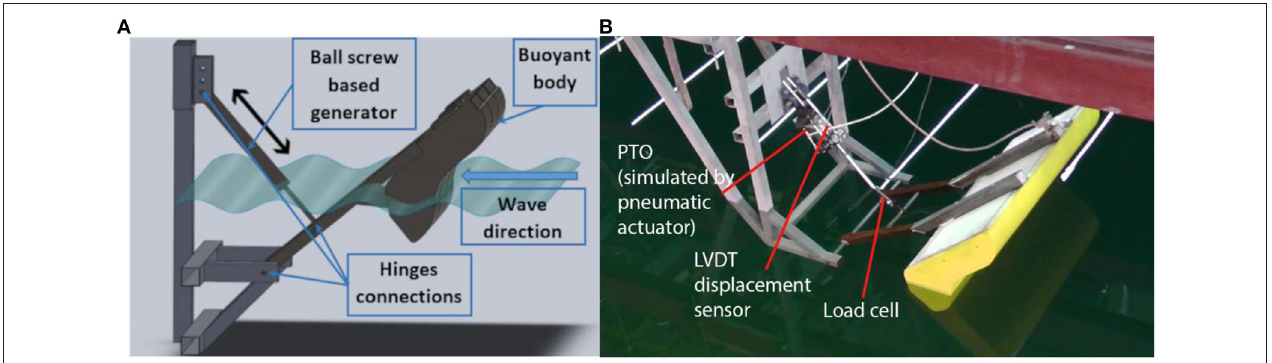
FIGURE 8 | Wave scatter matrix for a Tyrrhenian sea site, near Civitavecchia, derived from sea state time histories (2001–2010, ENEA numerical model).